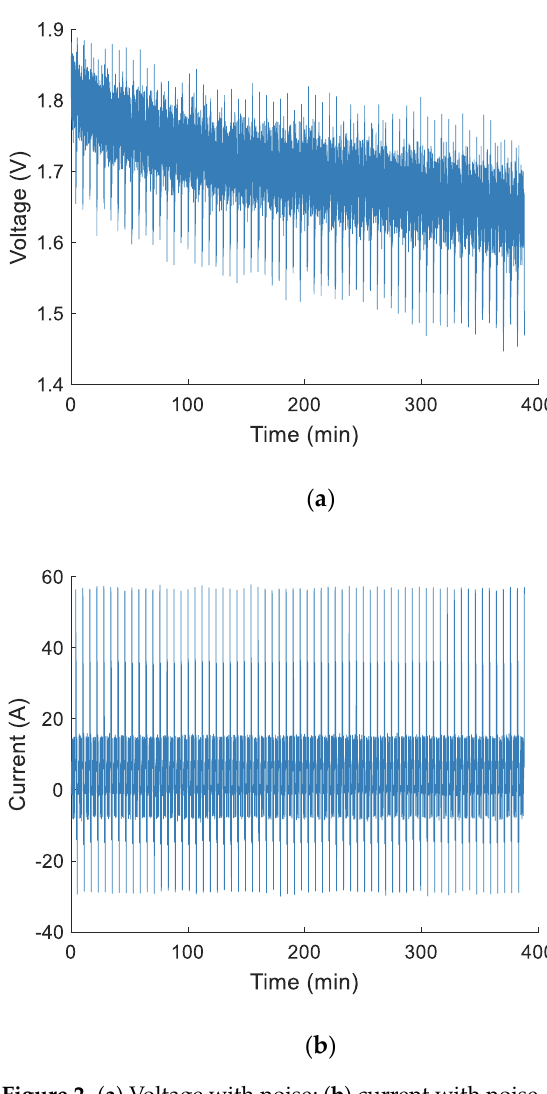
Figure 2. ( a ) Voltage with noise; ( b ) current with